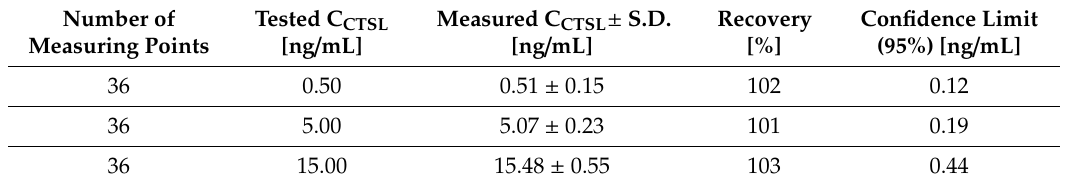
Table 2. Precision and accuracy of the Cathepsin-L (CTSL) quantification by Surface Plasmon Resonance Imaging (SPRI) method.